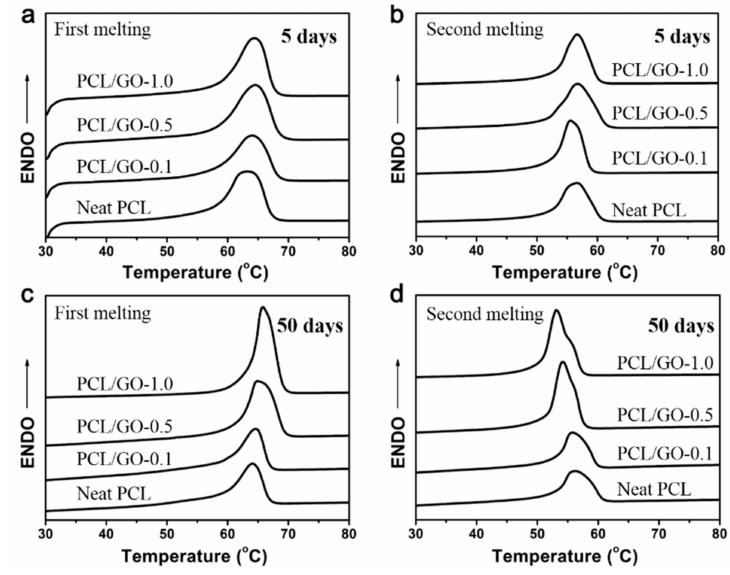
Figure 5. DSC curves of neat PCL and its nanocomposites. Table 1. Thermal data obtained from the 2D-SAXS and DSC results of samples after leaving 50